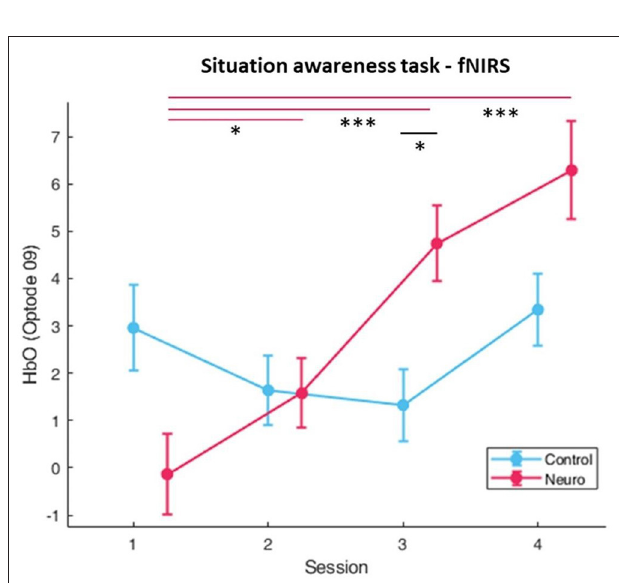
FIGURE 11 | fNIRS cognitive workload correlates as measured by oxygenated hemoglobin (HbO) in optode 4, the left prefrontal cortex, in the situational awareness task. Significant differences and interaction between group and session was found. Neuroadaptive group also showed higher HbO in session 3 (whiskers are SEM, * p < 0.05, *** p < 0.001).